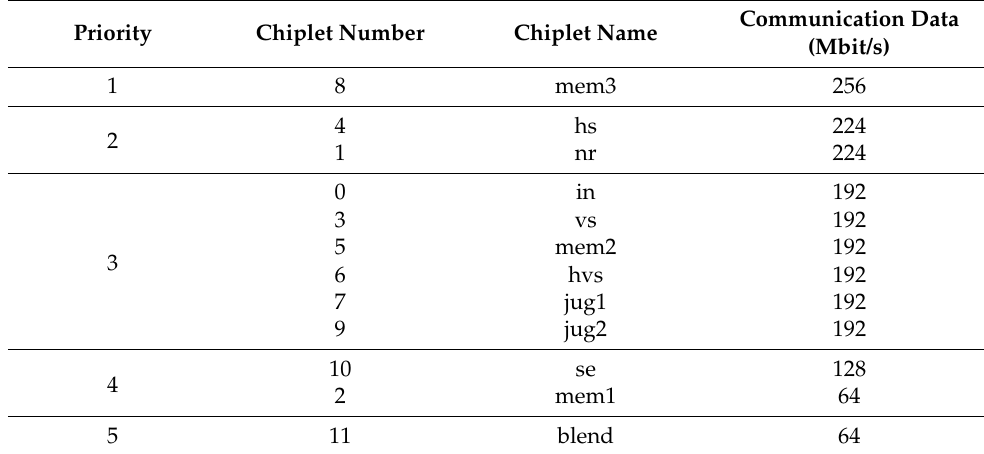
Table 1. Communication priority list of the multi-window display system.